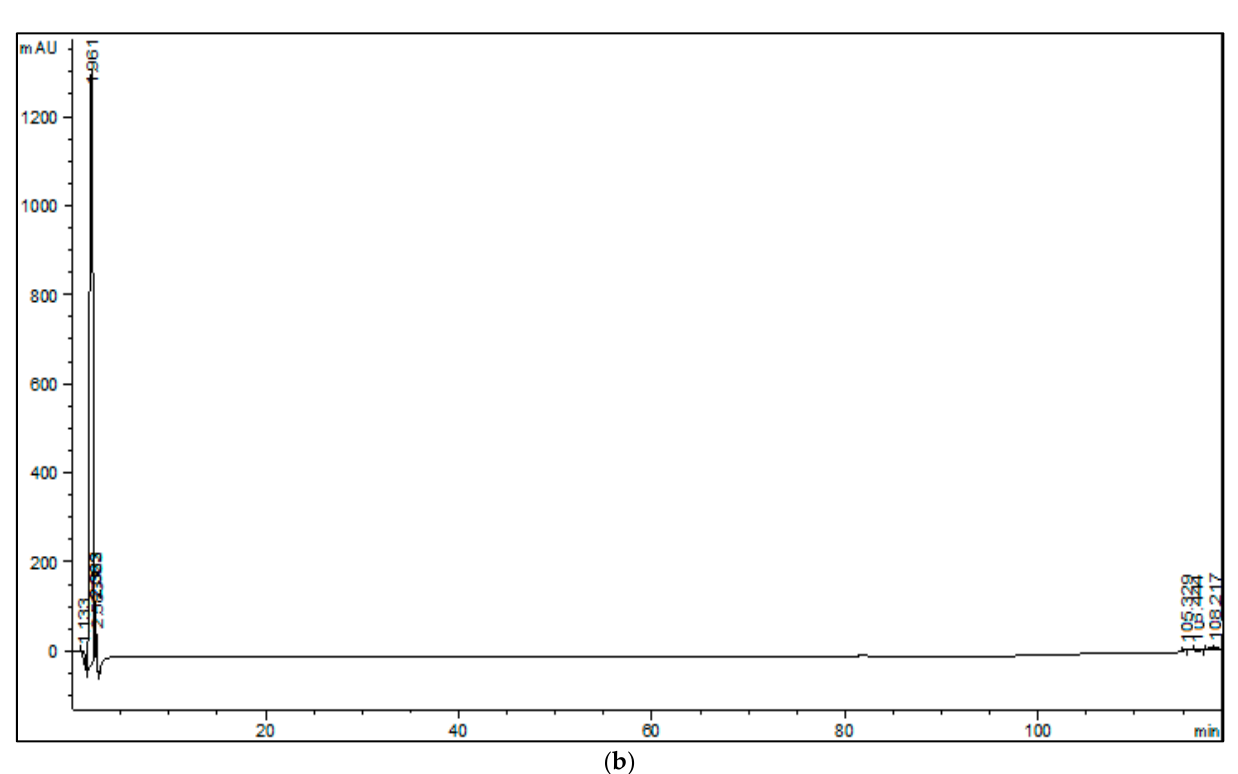
Figure 1. Chromatograms corresponding to the NPN fraction. ( a ) Chromatogram of the first ripening day. ( b ) Chromatogram of the last ripening day.